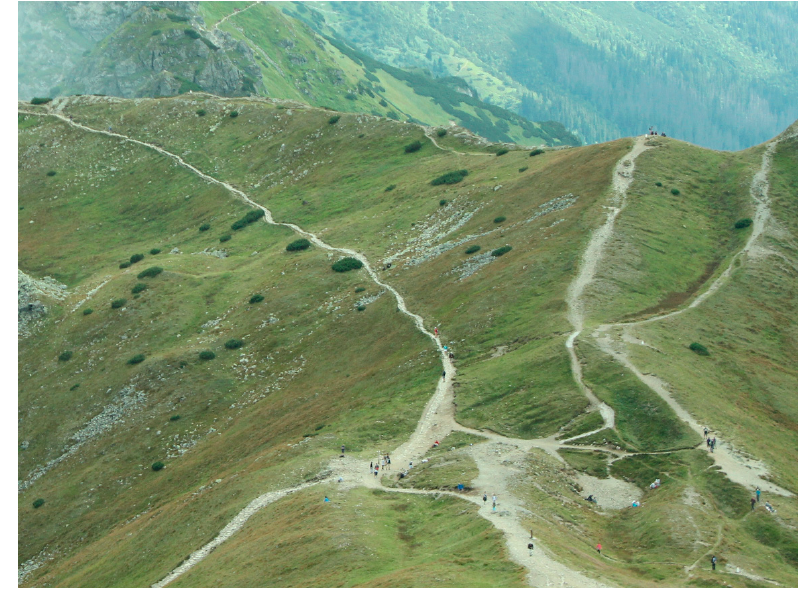
Figure 1. Photo of the trail running from the mountain pass under Kopa Kondracka.